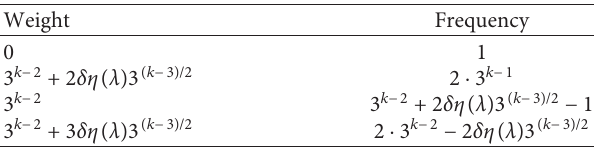
Table 6: Weight distribution of C Weight